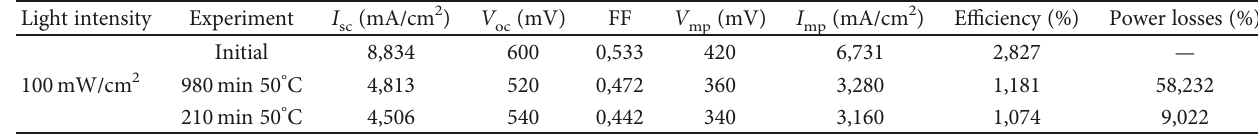
Table 7: Device 1 fi nger 1 50 ° C temperature degradation.